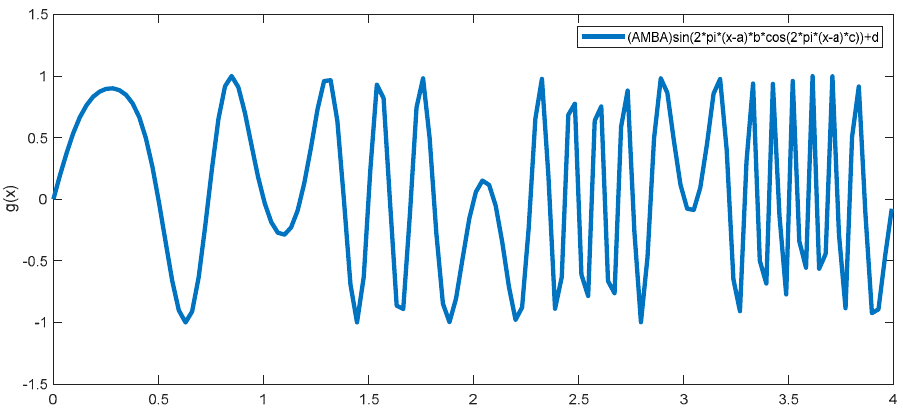
Figure 2. Generating function plotted with default values ( a = 0, b = 1, c = 0.5, and d = 0).